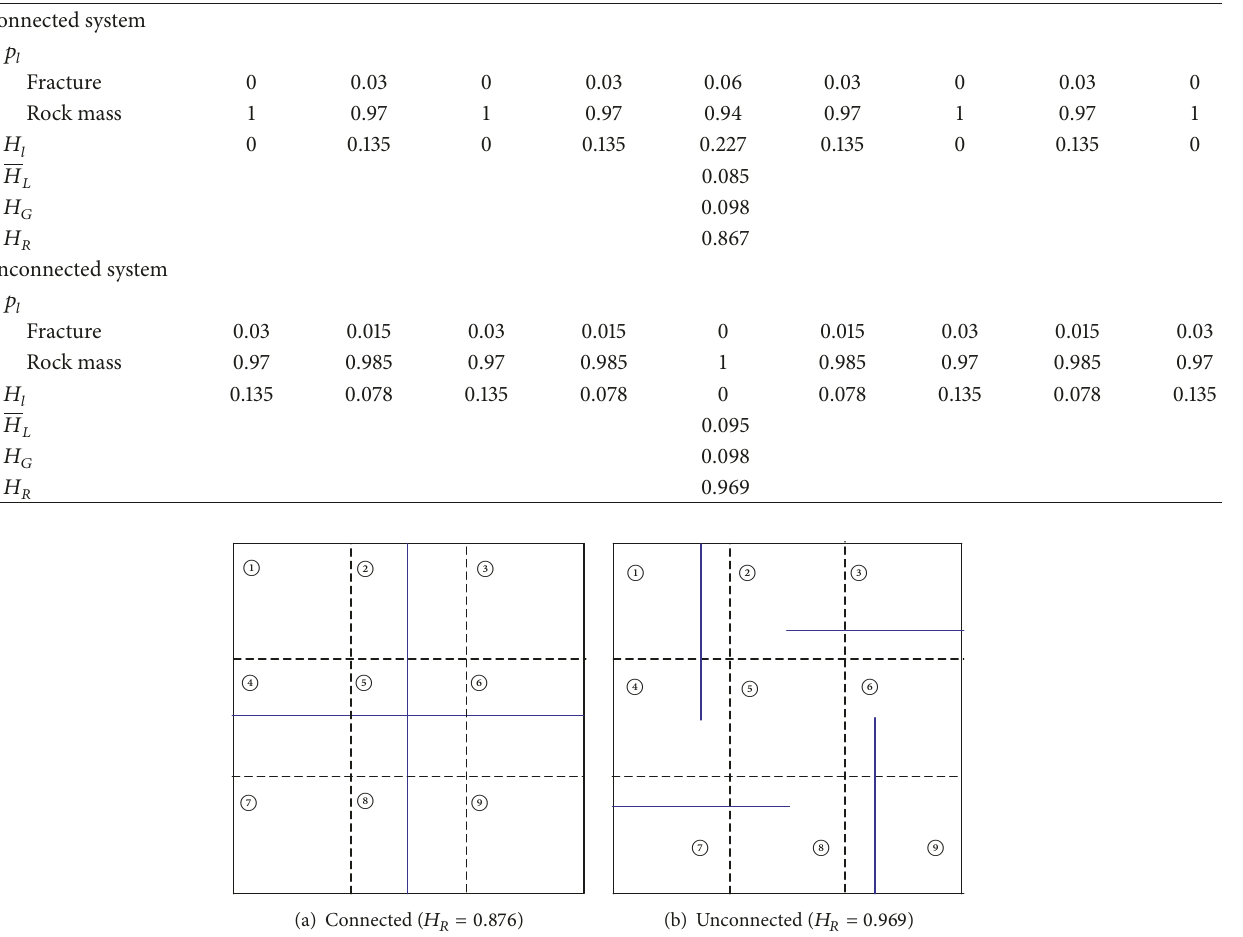
Figure 9: Local and relative entropy calculation for connected and unconnected